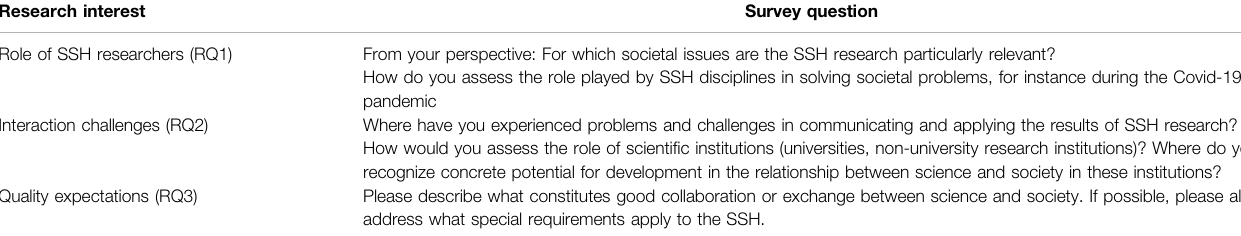
TABLE 2 | Research interest and survey